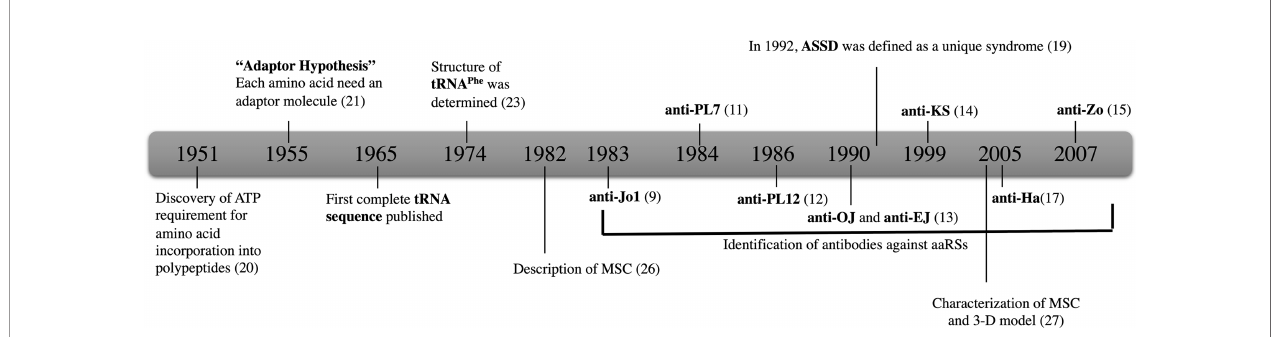
FIGURE 1 | The history of aaRSs and discovery of antibodies against eight aaRSs. Anti-Jo-1; HisRS, anti-PL-7; ThrRS, anti-PL-12; AlaRS, anti-OJ; IleRS, anti-EJ; GlyRS, anti-KS; AsnRS anti-Ha; TyrRS, and